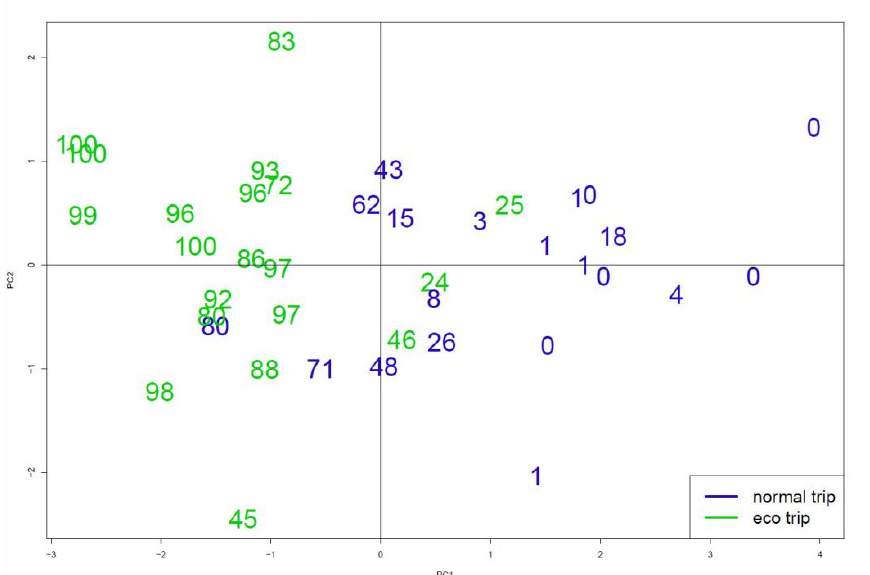
Figure 1. Principal component analysis and the estimated eco-index ("normal" trips are in blue, "eco" trips are in